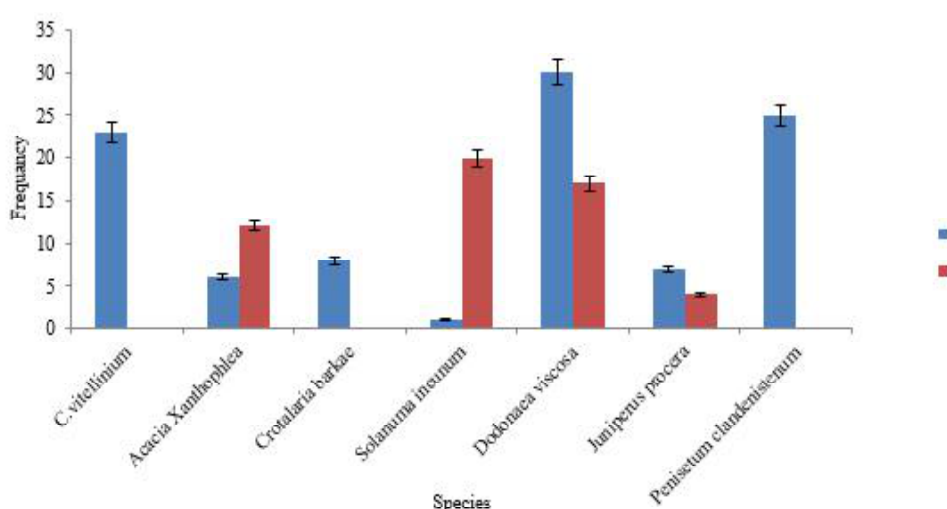
Fig. 6: Variation of common (dominant)plant species across the two study